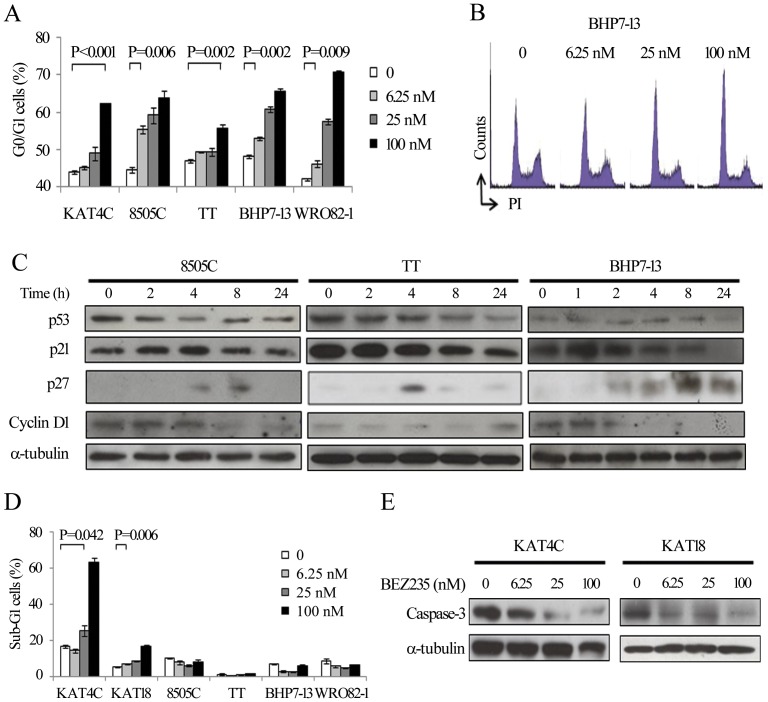
BEZ235 inhibits cell cycle progression at G0/G1 phase, and induces apoptosis in KAT4C and KAT18.A, analysis of cell cycle by measurements of DNA content revealed increasing doses of BEZ235 accumulates cells at G0/G1 by 24 hours (KAT4C, 8505C, BHP7-13 and WRO82-1) and 72 hours (TT). B, a representative cell line, BHP7-13 demonstrated cell cycle arrest at G0/G1 phase. C, cell cycle regulating proteins were evaluated using immunoblot in cells treated with BEZ235 at 100 nmol/L. p53 was decreased by 2 to 4 hours in 8505C and TT. BEZ235 gradually reduced p21 in TT and BHP7-13. p27 was increased in all cell lines. Cyclin D1 gradually decreased in 8505C and BHP7-13. D, apoptosis measured by flow cytometry to measure sub-G1 cells revealed that BEZ235 increases proportions of sub-G1 cells in KAT4C and KAT18 at 96 hours. E, immunoblot showed BEZ235 induced degradation of executioner caspase-3 in KAT4C and KAT18.